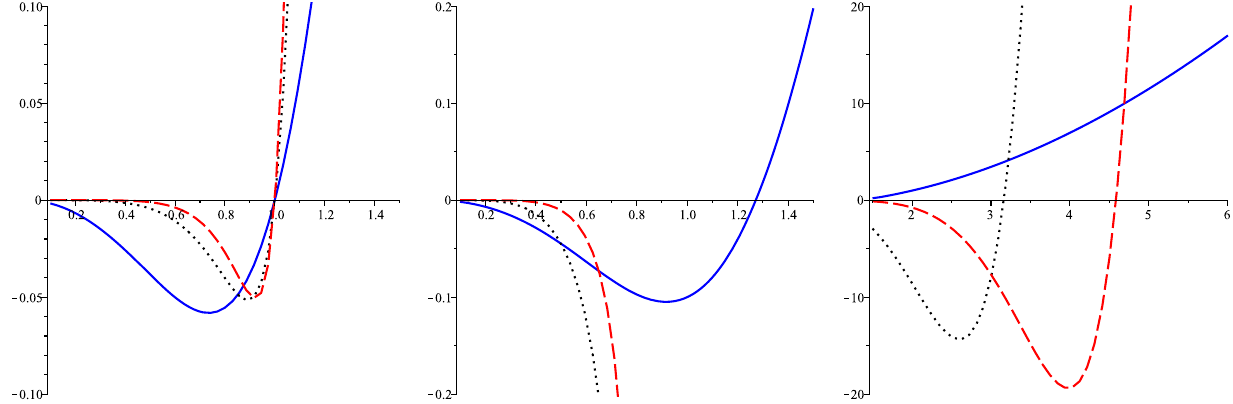
Fig. 3 C Q versus r + for q = 1, P = 1 / 8 π , d = 4 (solid lines), d = 7 (dotted lines) and d = 9 (dashed lines). Left panel for k = 0. Middle panel (0 < r + < 1 . 5) and right panel (1 . 4 < r + < 6) for k = − 1 with different